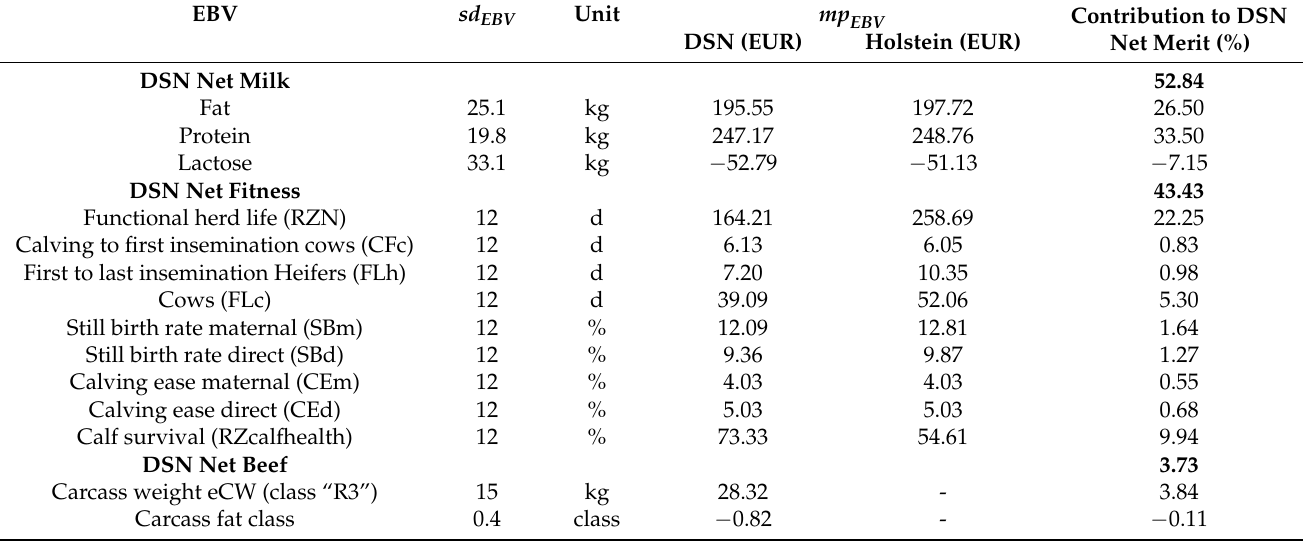
Table 1. EBVs included in the three sub-indices and their contribution to dual-purpose German Black Pied cattle breed net merit. Estimated breeding values included in the calculation of the DSN Net Merit composed of the sub-indices DSN Net Milk, DSN Net Fitness, and DSN Net Beef. For each EBV, the marginal profit in Euro per standard deviation is listed for DSN and German Holsteins [18]. Calculations of the marginal profit include the respective factor for lactation length and average number of lactations within each breed or number of calvings (3) during functional herd life. Furthermore, the financial contribution (in%) of each sub-index to DSN Net Merit is listed. Equations for the calculation of the marginal profit of EBVs are listed in Tables S2 and